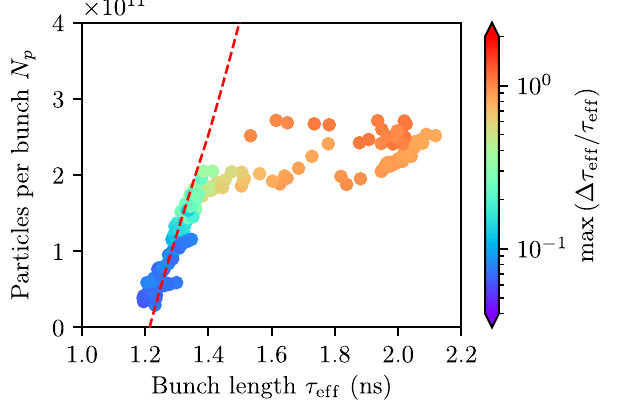
17. The maximum oscillation amplitude of the bunch length during acceleration for different intensities and bunch lengths at the arrival at the SPS flattop obtained from measure- ments [18]. The red dashed line corresponds to computed bunch parameters with a constant emittance of ϵ ¼ 0 . 33 eVs.